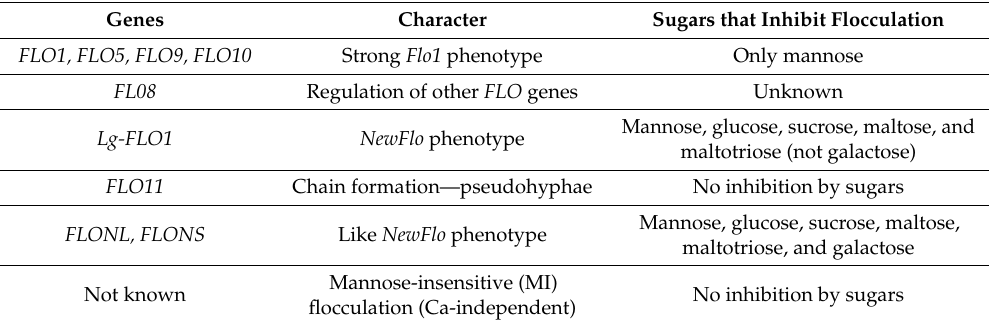
Table 1. Current view of flocculation phenotypes